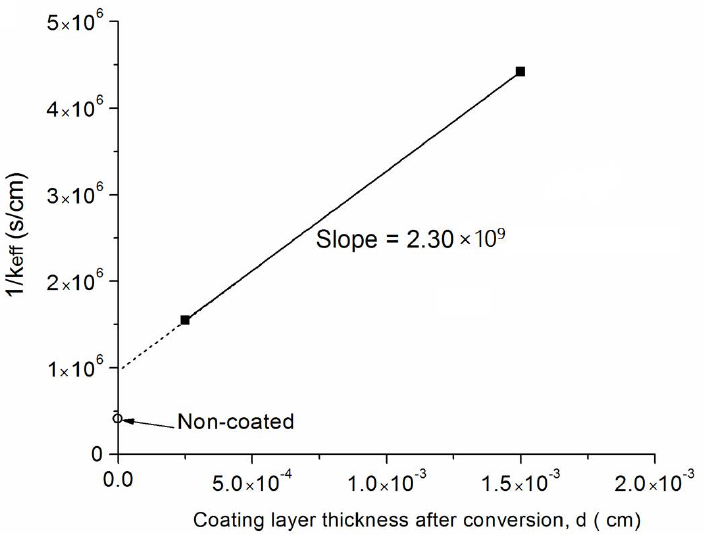
Figure 9. A schematic showing the variation of the chemical potential of Na 2 O, µ Na sample with surface layer of Na- β ”-alumina of thickness, δ .